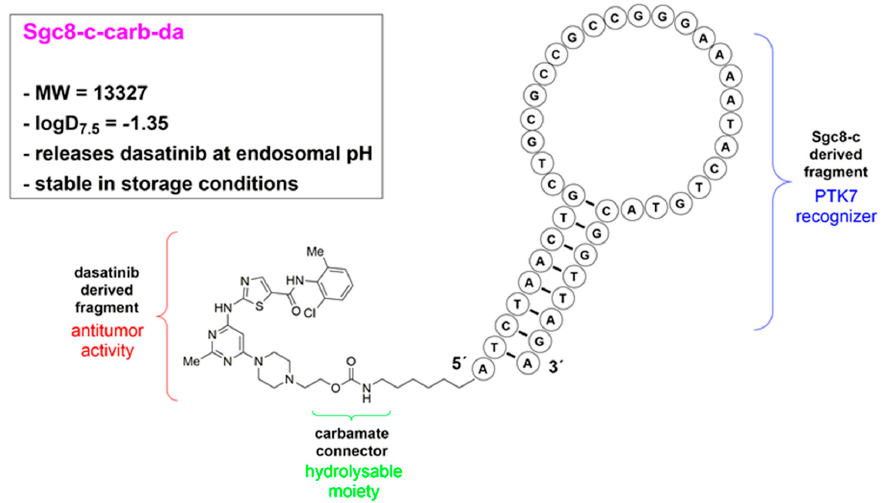
Figure 1. Schematic representation of Sgc8-c-carb-da structure and characteristics. Fragments cor- respond to anti-tumour activity (dasatinib-derived moiety), target recognition (Sgc8-c-derived frag- ment), and carbamate connectors (hydrolysable at endosomal pH [27]).